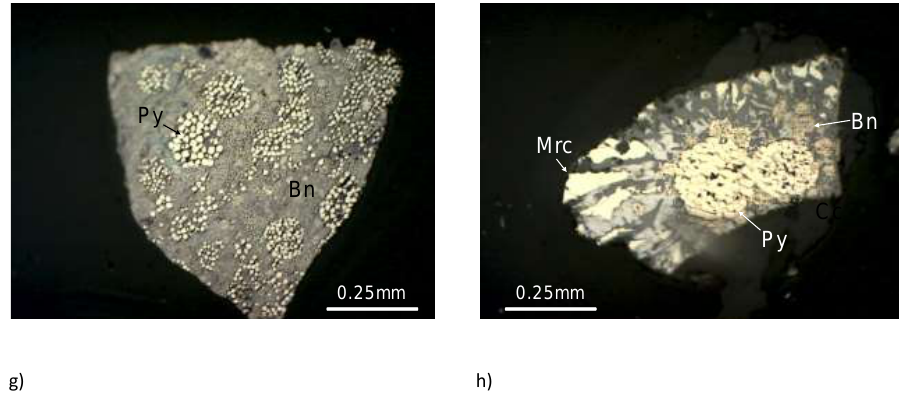
Figure 4. Microphotography of ore minerals separated as heavy fractions from ZM sediments under reflected light: ( a ) digenite (Dg) and bornite (Bn) in intergrowths with dolomitic ore ZM, northern dam, N19A; ( b ) bornite (Bn), digenite (Dg), covellite (Cv), and yarrovite (Yar) in sandstone fragment, profile N19A; ( c ) bornite (Bn) overgrowths on tennantite (Tnt) and chalcopyrite (Ccp) included in gangue minerals, profile N19B; ( d ) bornite (Bn) overgrowths on covellite (Cv) as a part of the dolomitic fragment, chalcopyrite (Ccp) as a separate grain, northern dam, profile N19B; ( e ) galena (Gn) and sphalerite (Sp) intergrowths, northern dam, profile N19B; ( f ) galena (Gn) surrounded by cerussite (Cer) western dam, sample W3; ( g ) pyrite framboids cemented by bornite (Bn) western dam, W1; ( h ) pyrite framboids in early form of automorphic grains inside bornite (Bn) and marcasite (Mrc) intergrowths, N19A; 1 polarizer, reflected